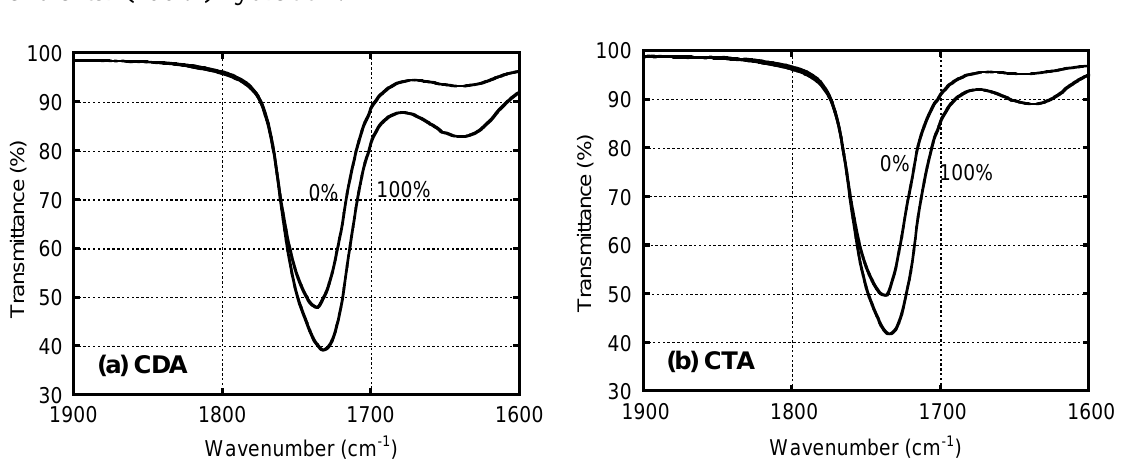
Figure 9. ATR-FTIR spectra (1,600–1,900 cm −1 ) of (a) CDA and (b) CTA before (0%) and after (100%)